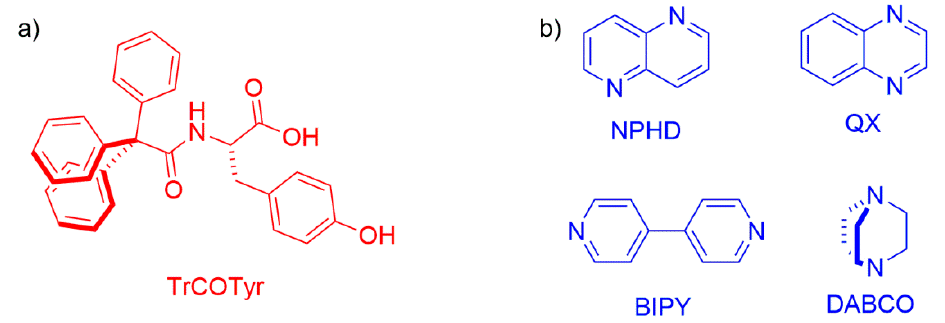
Figure 1. Molecular structure of the compounds under study: ( a ) the host N -triphenylacetyl- l -tyrosine Figure 1 . Molecular structure of the compounds under study: ( a ) the host molecule (TrCOTyr, red color); ( b ) the guests (blue color): 1,5-naphthyridine (NPHD), quinoxaline N- triphenylacetyl- L -tyrosine molecule (TrCOTyr, red color); ( b ) the guests (blue color): (QX), 4,4 (cid:48) -bipyridyl (BIPY), and 1,4-diazabicyclo[2.2.2]octane 1,5-naphthyridine (NPHD), quinoxaline (QX), 4,4 ′ -bipyridyl (BIPY), and 1,4-diazabicyclo[2.2.2]octane (DABCO).